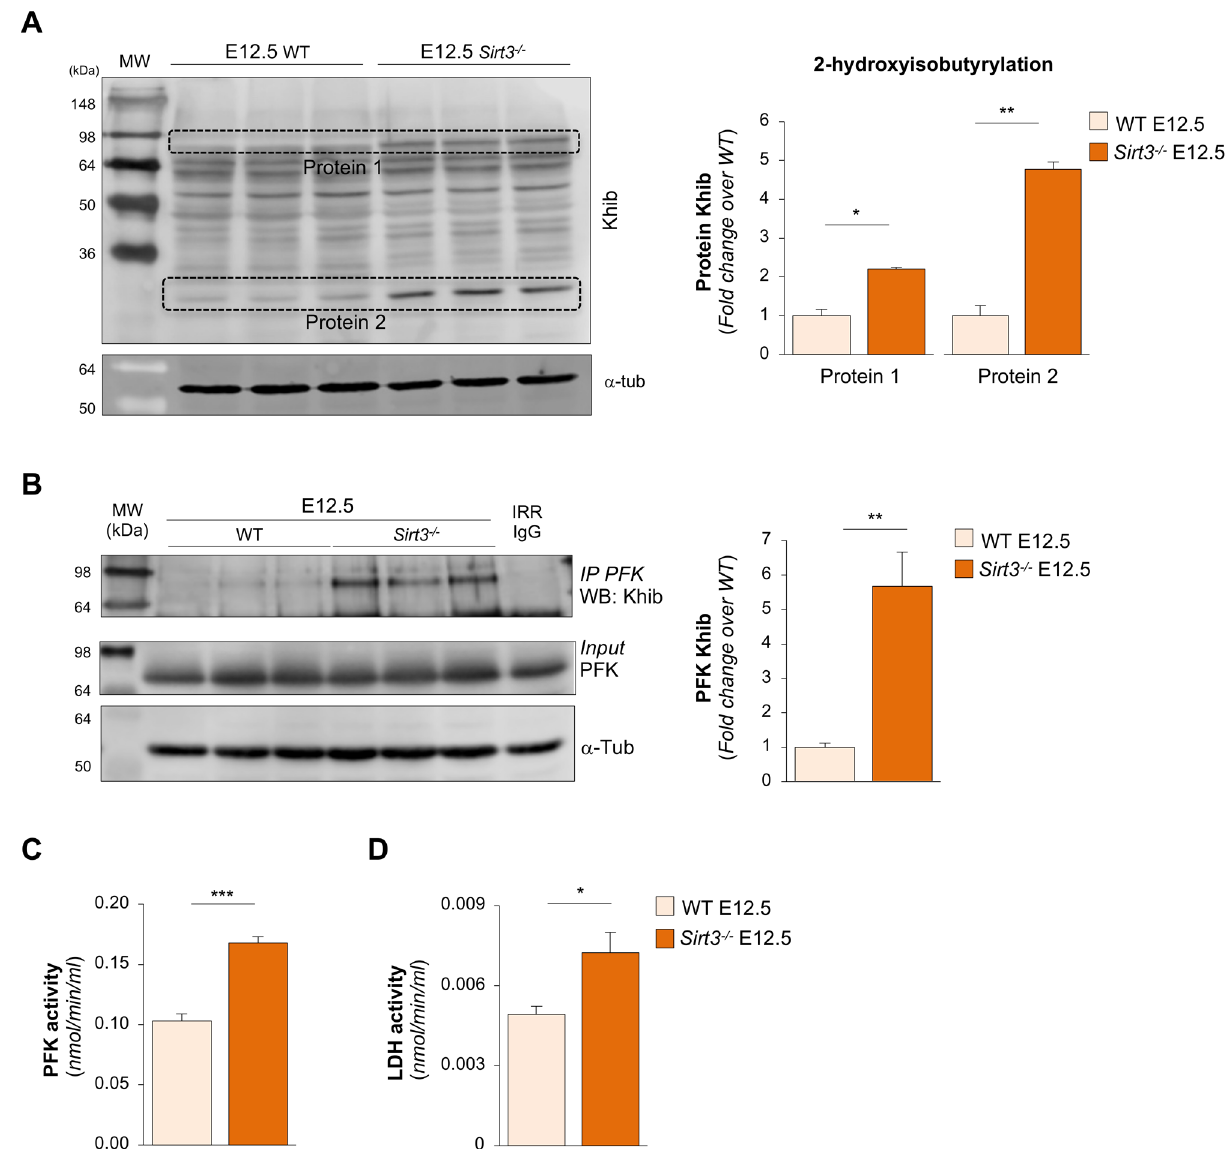
Figure 4. SIRT3 regulates glycolysis in the embryonic kidney via 2-hydroxyisobutyrylation. ( A ) Representative Western blots of lysine 2-hydroxyisobutyrylation (Khib) on non-histone proteins in total extracts harvested from WT and Sirt3 −/− kidneys on E12.5 ( n = 3 samples per group, each sample is the pool of 15 metanephroi). α-tubulin (α-tub) was used as sample loading control. Quantification of the Khib levels of two specific proteins (dotted boxes) found to be hyper-Khib in Sirt3 −/− kidneys on E12.5. ( B ) Western Blot (WB) of Khib in total extracts from WT and Sirt3 −/− kidneys on E12.5 immunoprecipitated phosphofructokinase (PFK). Normal rabbit IgG was used as an irrelevant isotype control (IRR IgG). Input identifies the basal expression of PFK and normalized for α-tub as sample loading control by WB in total extracts from WT and Sirt3 −/− kidneys on E12.5 ( n = 3 samples per group, each sample is the pool of 15 metanephroi). ( C ) PFK activity assed by colorimetric assay kit in total extracts from WT and Sirt3 −/− kidneys on E12.5 ( n = 4 sample per group, each sample is the pool of 10 metanephroi). ( D ) Lactate dehydrogenase (LDH) activity assessed in total extracts from WT and Sirt3 −/− kidneys on E12.5 ( n = 6 sample per group, each sample is the pool of 15 metanephroi). Molecular weights (MW) are reported in each representative Western Blot and expressed in kDa. Data represent mean ± s.e.m. and were analysed with Student’s t-test. * P < 0.05, ** P < 0.01, and *** P <